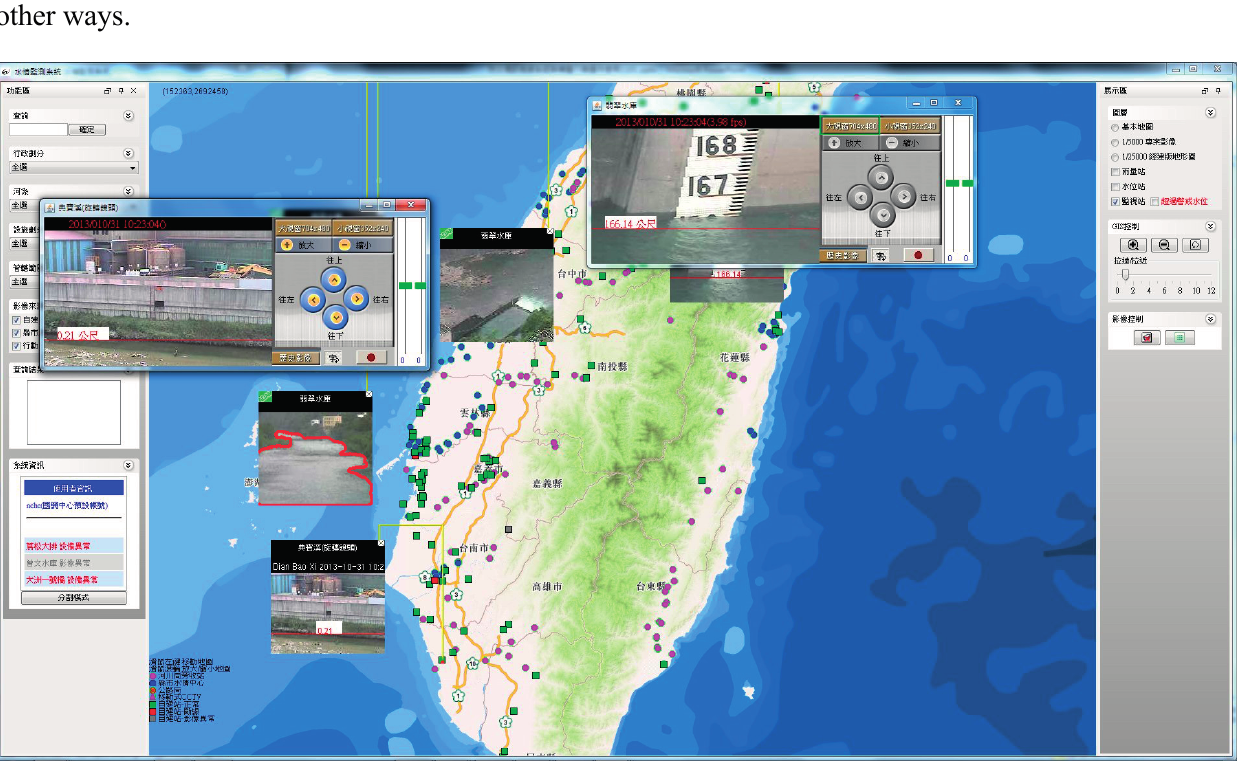
Figure 6. Online user interface. Appearance of the hydrological monitoring and flood risk warning system in operation. If any monitoring station reaches a risk level of 80%, the video from the on-site camera directly pops up on the interface, with a red outline indicating the near real-time detected flooding